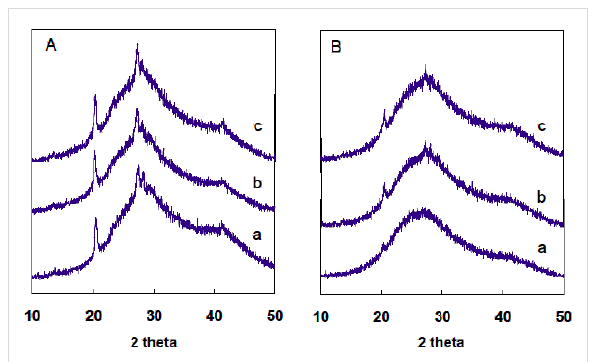
Figure 5: XRD profiles of LPEI aggregates (A) and LPEI@silica hybrid nanostructures (B). The LPEI aggregates were prepared by dropping 5.0 M NaOH solution into a mixture of 0.5 g of LPEI·HCl and 6 mL of water with ratios [OH]/[EI] of 0.8 (a), 1.6 (b) and 3.2 (c). The silica deposition conditions are the same for a, b and c: 1.5 mL of MS51 was added into 15 mL of aqueous dispersion of LPEI aggregates (pH 7.0) and stirred for 1 h at room